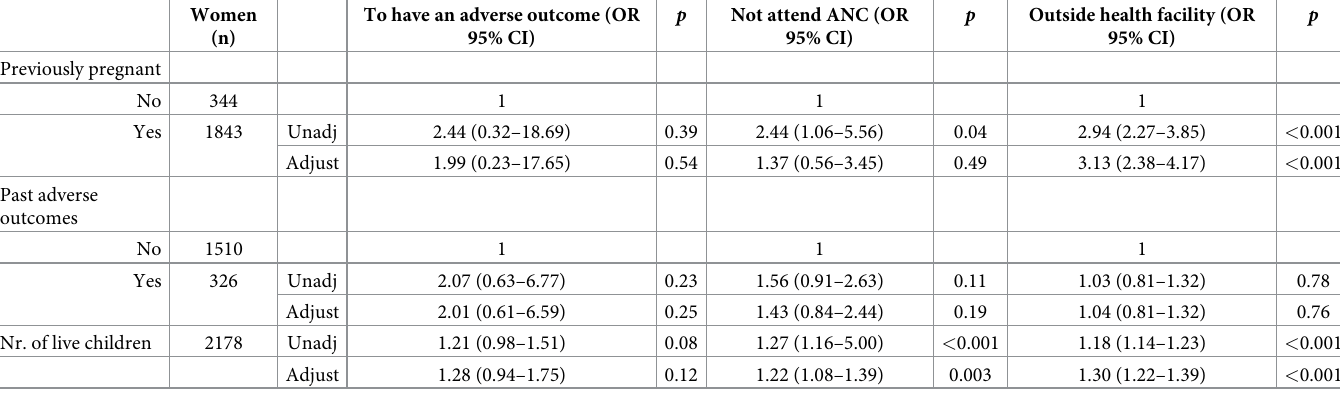
Table 3. Unadjusted and age adjusted Odds Ratios (OR, 95% CI, p) for having an adverse pregnancy outcome, not attend ANC, and deliver outside a health facility, against three explanatory variables related with women’s history of pregnancy.